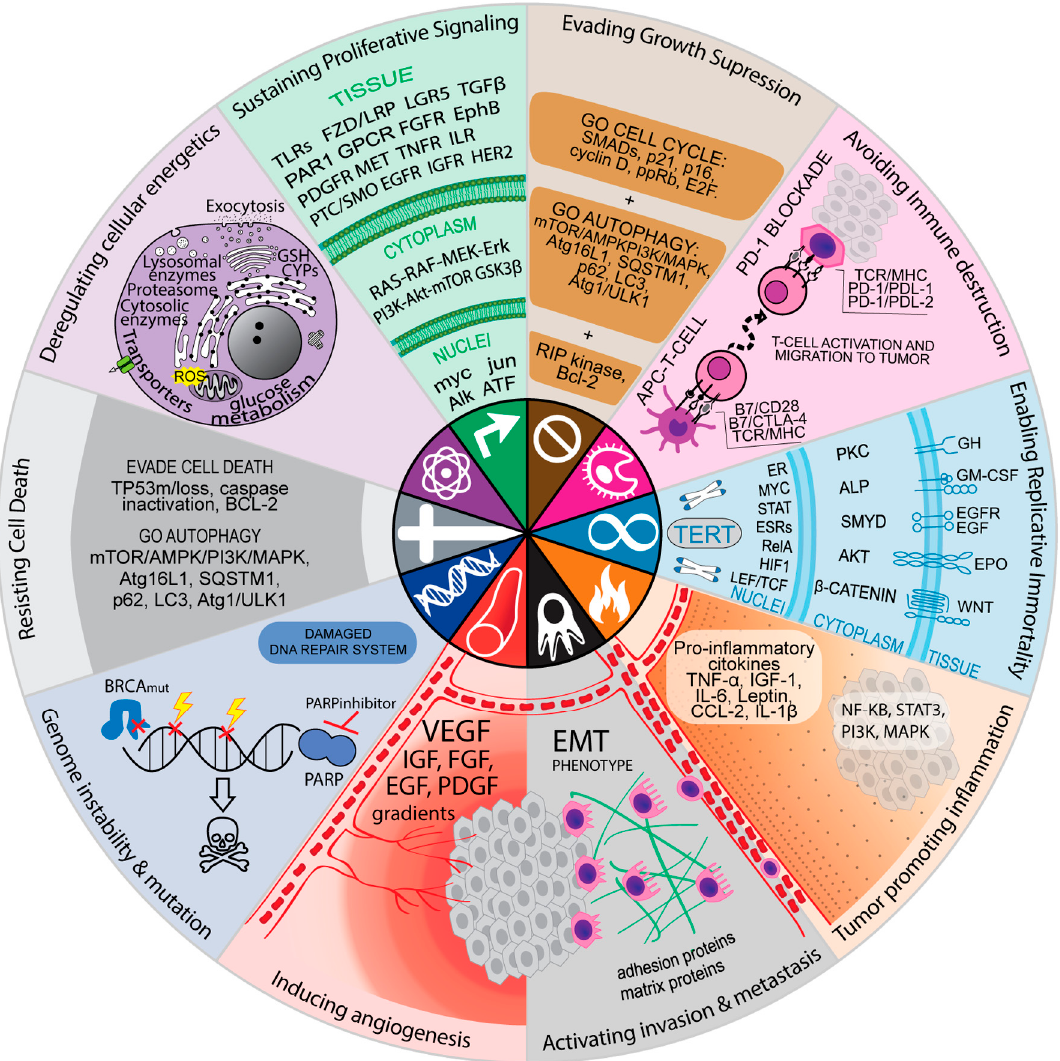
Figure 1. Targets of approved or investigational pharmacological intervention on signaling pathways associated with resistance mechanisms against antineoplastic agents and their associations with the hallmarks of cancer. The hallmarks of cancer [91] are sustaining proliferative signaling, evasion of growth suppression, avoiding immune destruction, enabling replicative immortality, tumor-promoting inflammation, activation invasion and metastasis, inducing angiogenesis, genome instability and mutation, resisting cell death, and deregulating cellular energetics. The most commonly affected signaling pathways in response to cytotoxic or targeted chemotherapeutic agents related to specific resistance mechanisms are depicted. For more details, please consult the supplementary tables. Adapted from Hanahan and Weinberg (2011) [91].